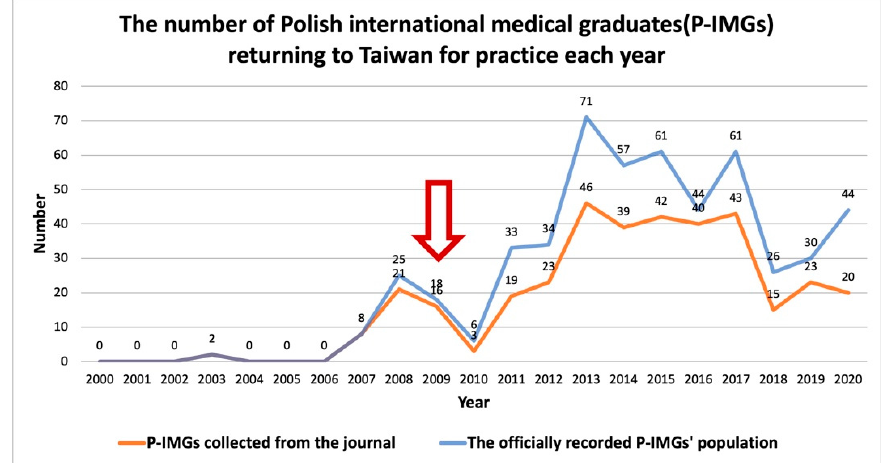
Figure 1. The number of Taiwanese who graduated from a Polish medical school (P-IMGs) and returned to Taiwan to practice each year. The red arrow represents the year that the mass demonstration between P-IMGs and domestic medical graduates was held.